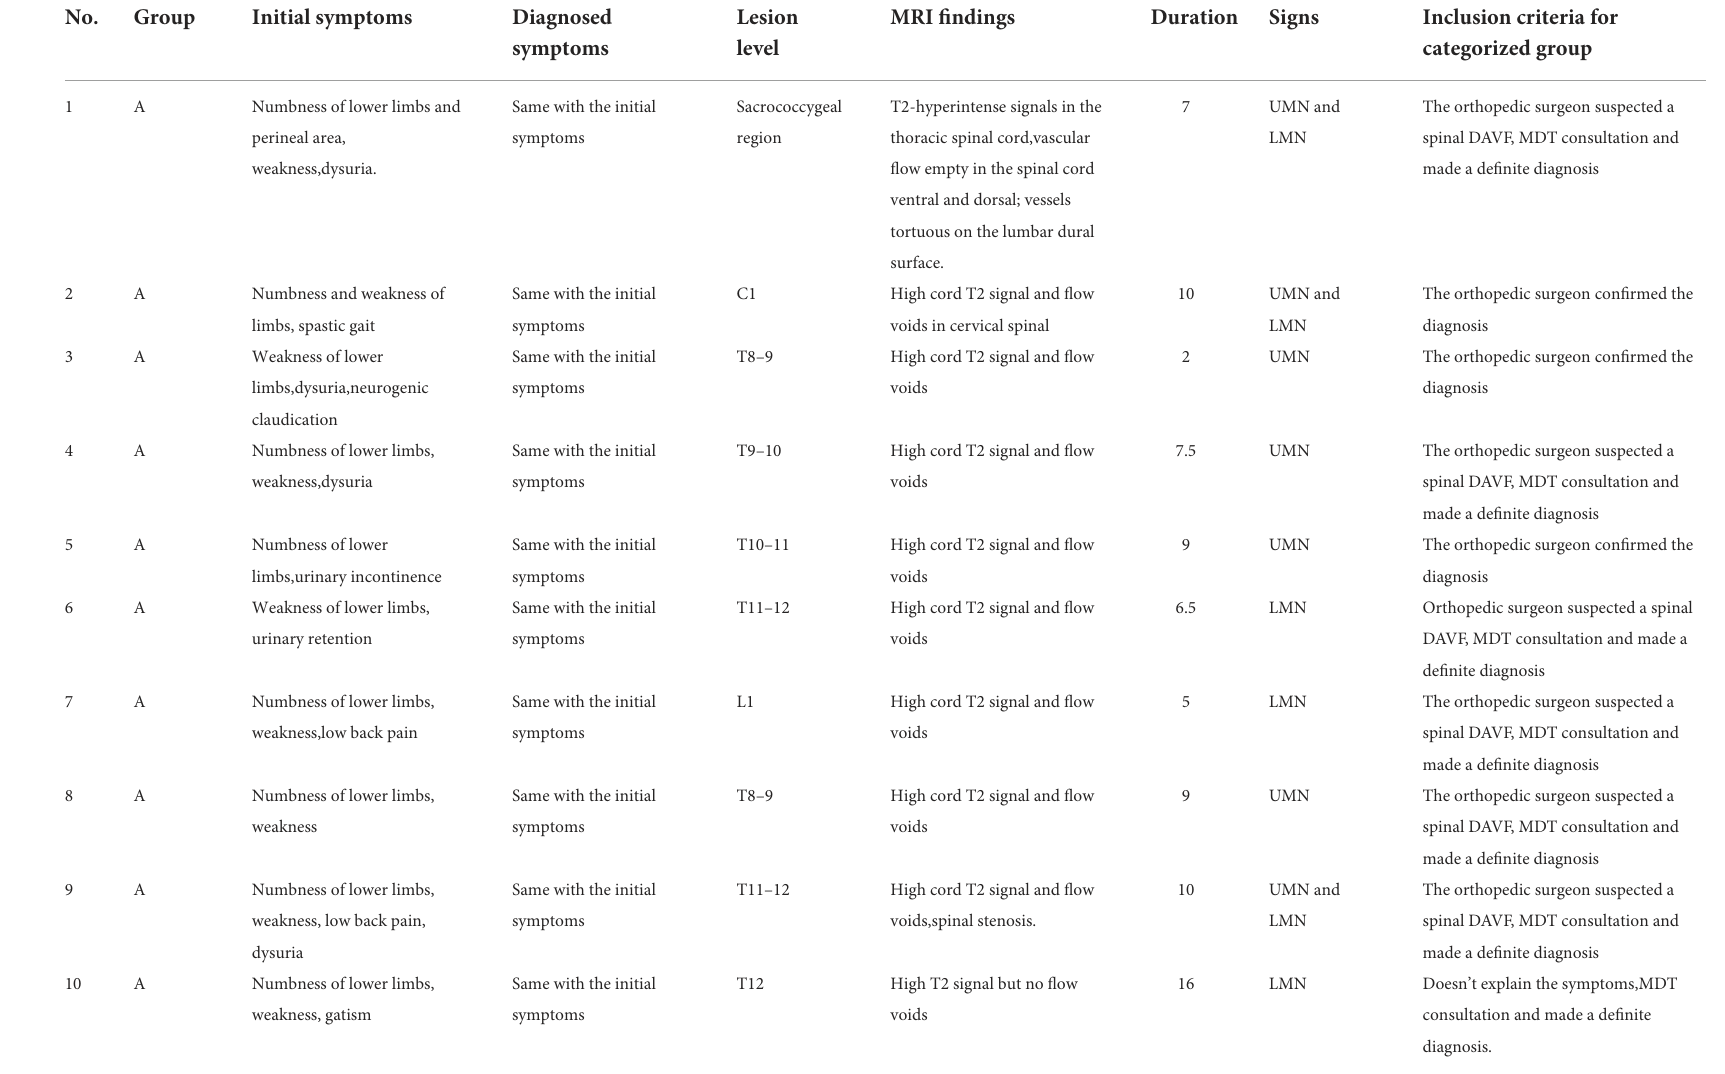
TABLE 3 Clinical characteristics of the included 22